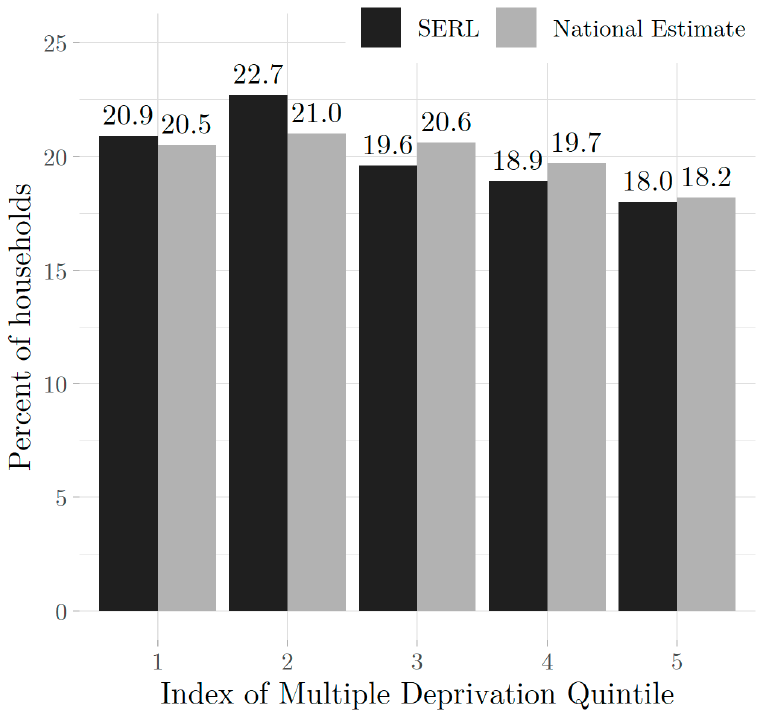
Figure 8. Percentage of the SERL Observatory in each Index of Multiple Deprivation quintile compared with our national estimate from Address Base.